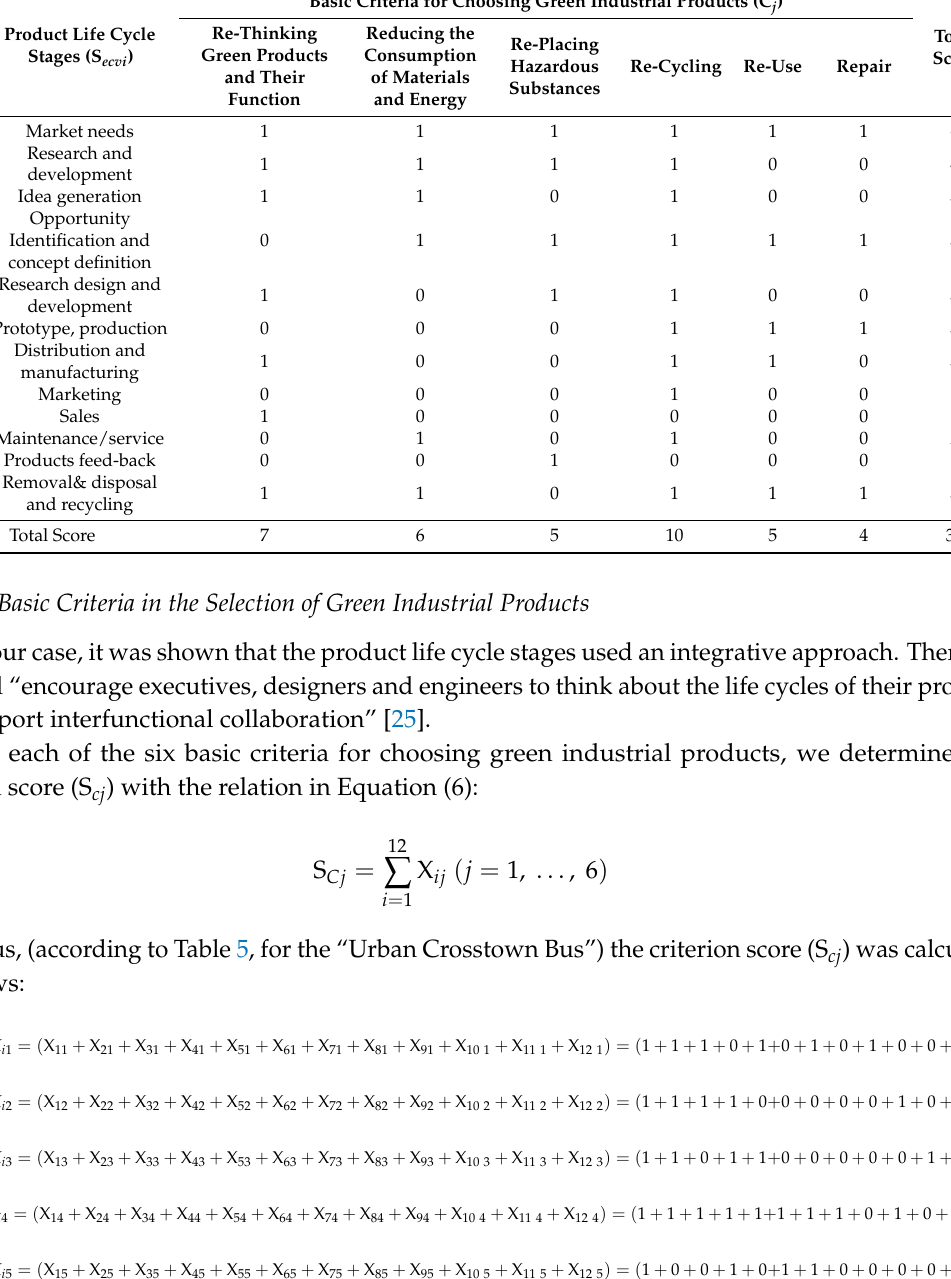
Table 5. Determination of the green industrial performance of the “Urban Crosstown Bus”.